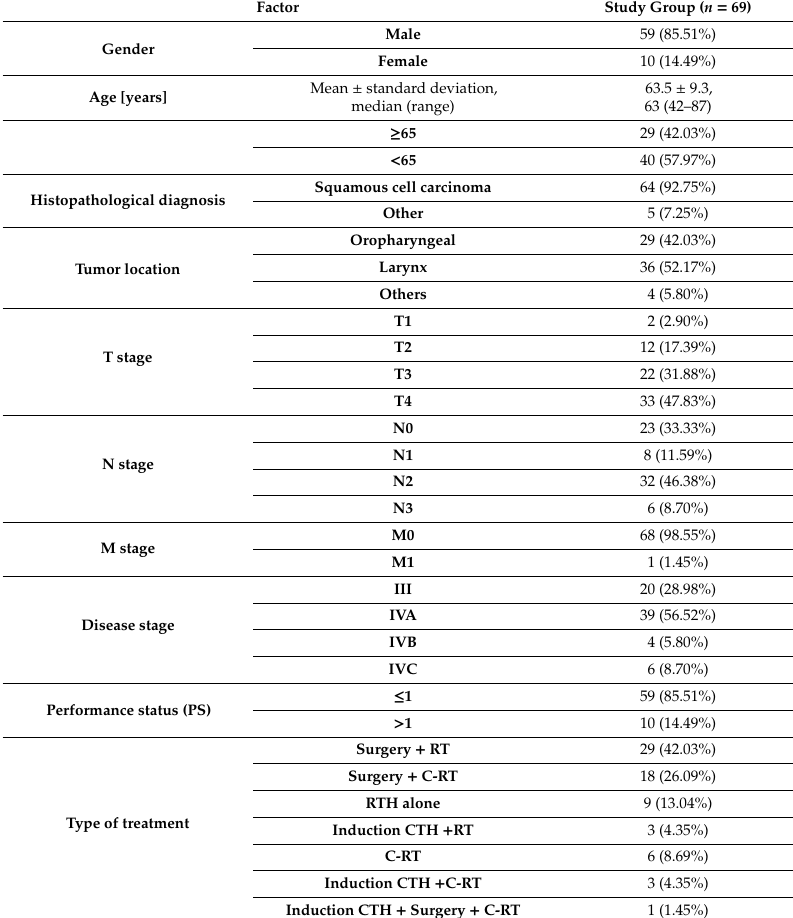
Table 1. General characteristics of the study